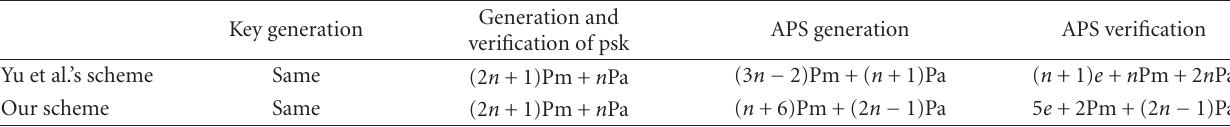
Table 2: Comparison of computational costs of our scheme and Yu et al.’s scheme. Key